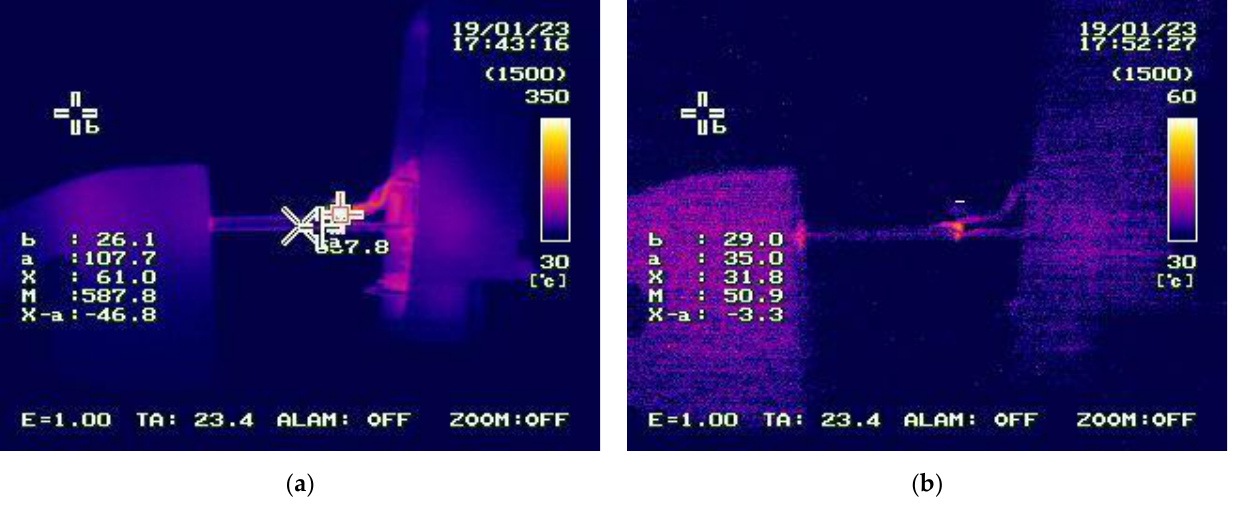
Figure 5. Thermal images of the system state with and without an arc fault. The arc fault was maintained for 2 min. The temperature around the contact point did not reach 700 °C. ( a ) 4 A, 2-min arcing. ( b ) 4 A, initial state. Table 1. Resistance and temperature in a copper-to-copper glowing